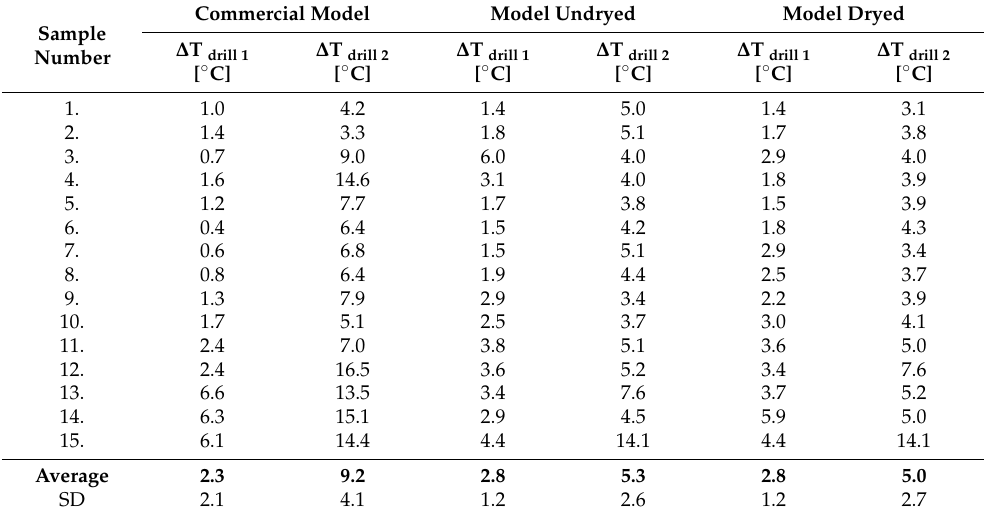
Table 2. The results of the temperature change during cutting for the undried and dried models with the composition of PC–700 g, PO–5.0 g, talc − 3.5 g in comparison with the commercial model. The temperature increase ( ∆ T) for drill 1 and drill 2 separately was calculated as the difference between the highest temperature obtained in the drilling process and the initial temperature of the analyzed surface. Standard divination (SD) was also calculated. Commercial Model Model Undryed Model Sample Number